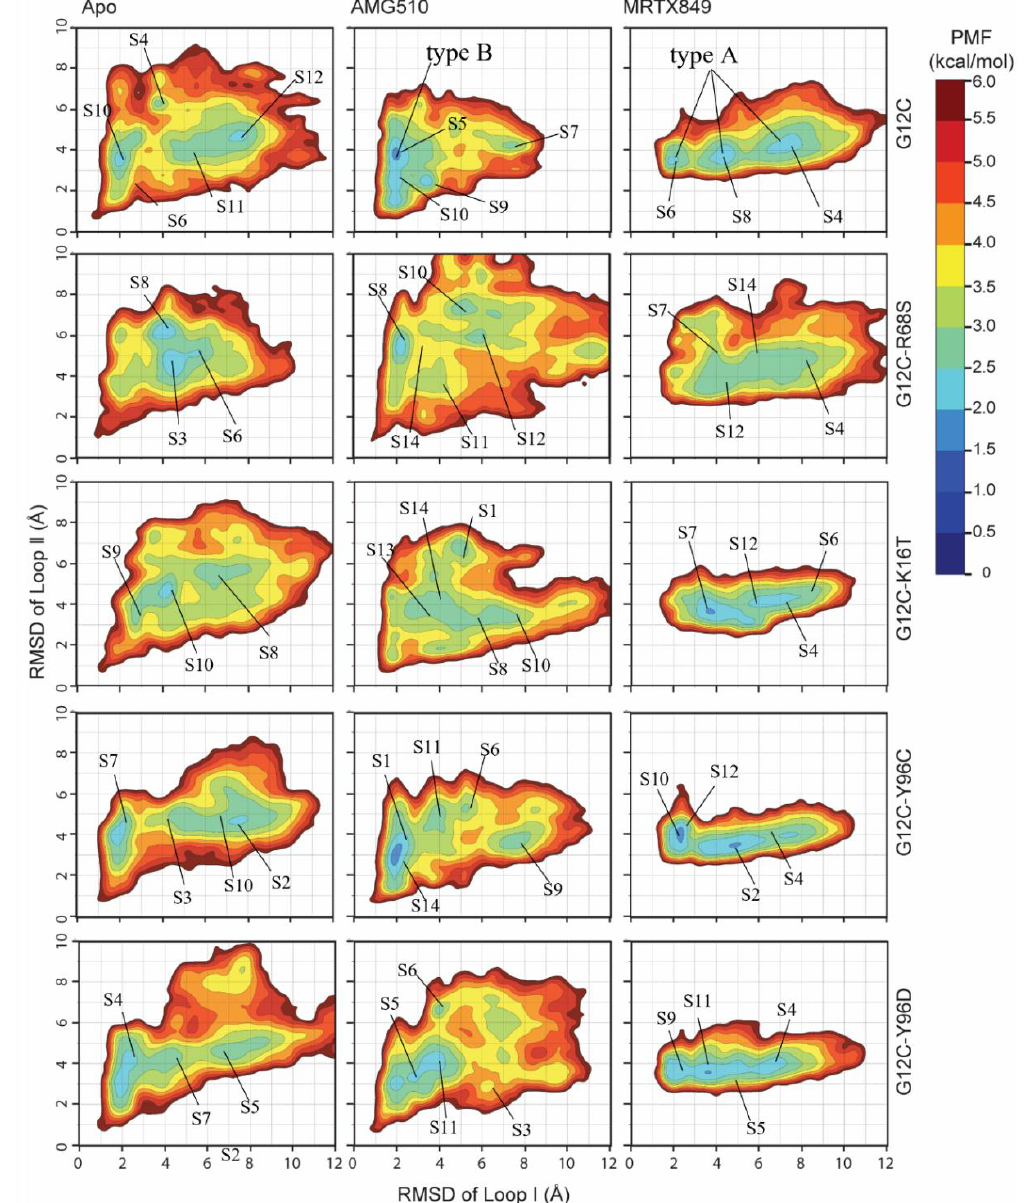
Figure 9. 2D potential of mean force (PMF) profiles of protein Loop I and Loop II of RMSDs as reaction coordinates. The first column displays the corresponding apo form KRAS G12C and four second-site mutilation KRAS. The second column pictures the AMG510 bound to KRAS G12C and four second-site mutilation KRAS. The third column depicts the MRTX849 bound to KRAS G12C and four second-site mutilation KRAS.